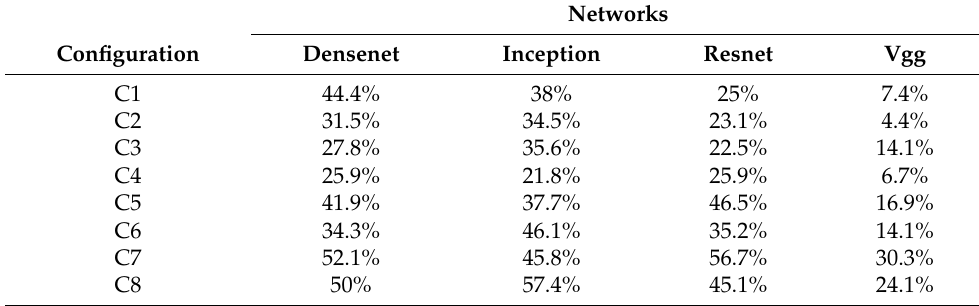
Table 9. Rejection rate after ROC